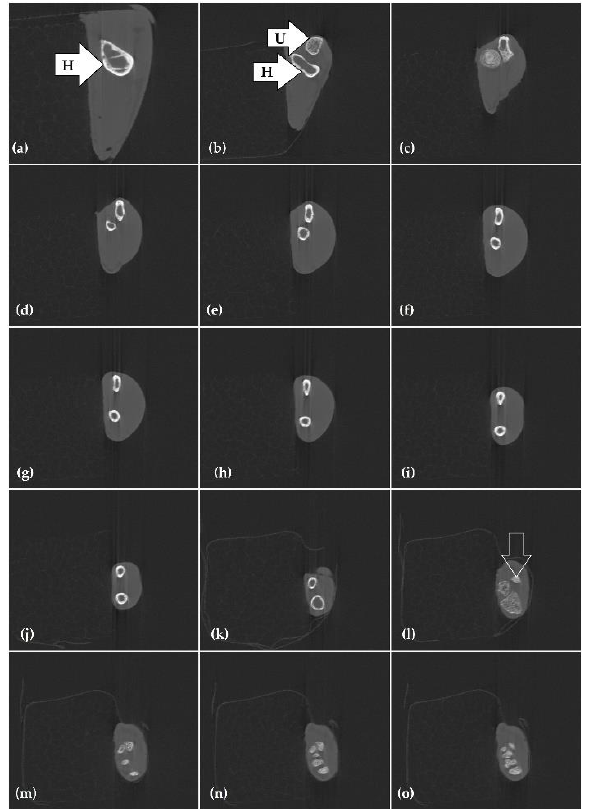
Figure 2. Sagittal microcomputed tomography images of the L. chrysomelas forearm. Transversal bone density: ( a ) humerus—H.; ( b , c ) humerus—H, ulna—U; ( d – l ) upper bone—ulna, lower bone—radius; ( l ) arrow—accessory carpal bone; ( m – o ) carpal bones.